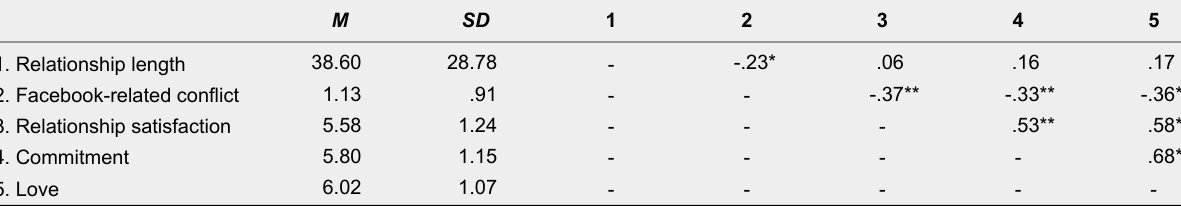
Means, Standard Deviations, and Correlations for